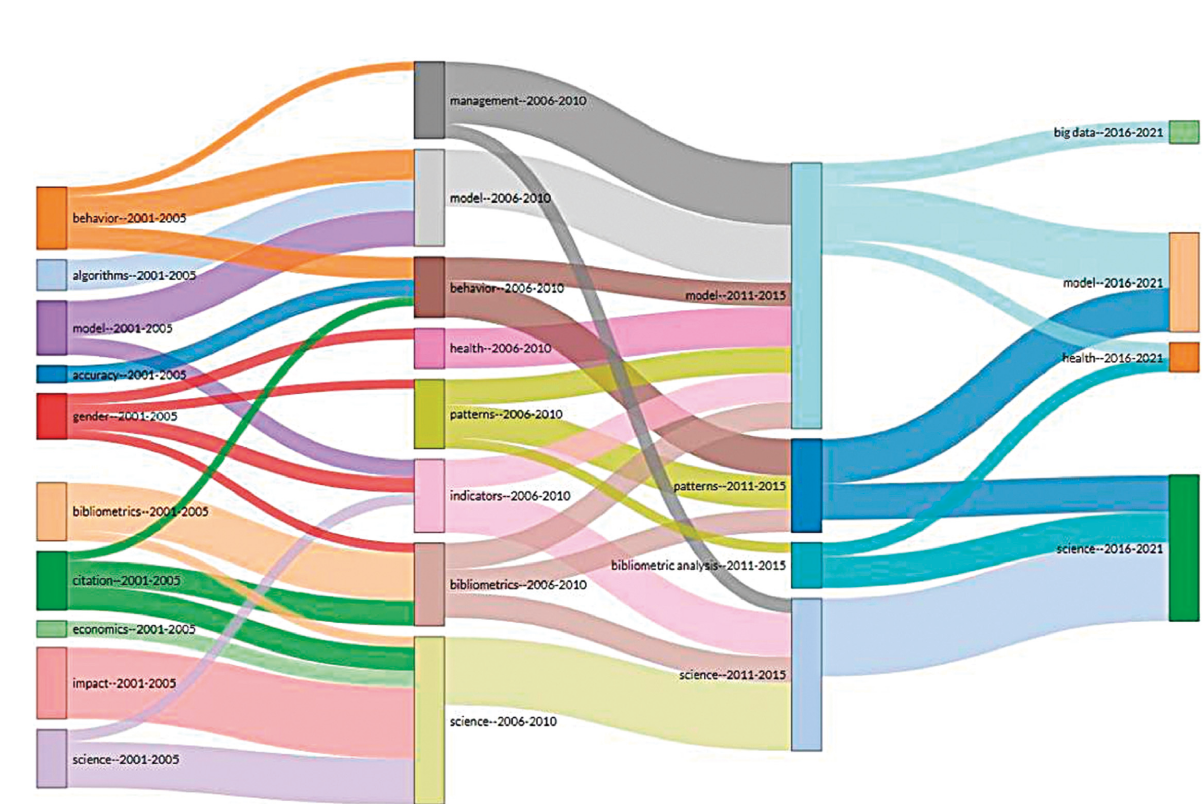
Figure 15: Thematic evolution of computational social